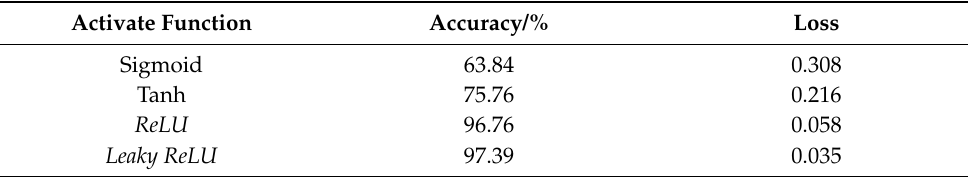
Table 6. Experimental comparison results of different activation functions.